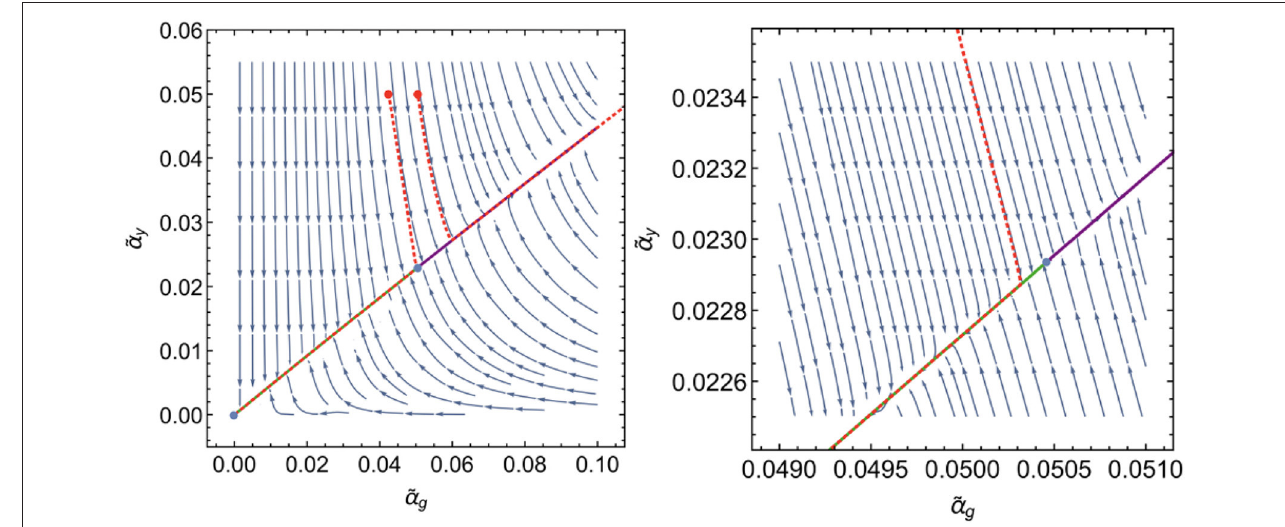
FIGURE 6 | The flow toward the IR from the fixed point in Equation (36) for ǫ 1 / 10 features one strongly IR attractive and one weakly IR repulsive direction. The = green and purple, thick, continuous lines are the two only “true” fixed-point trajectories. Initial conditions in the UV away from the fixed point (red dots) result in trajectories that are indistinguishably close to the fixed-point trajectories in the IR. The right panel shows a zoom into the vicinity of the fixed point, where the “non-fundamental” trajectory narrowly misses the fixed point, but approaches the critical hypersurface arbitrarily closely, resulting in universal predictions in the